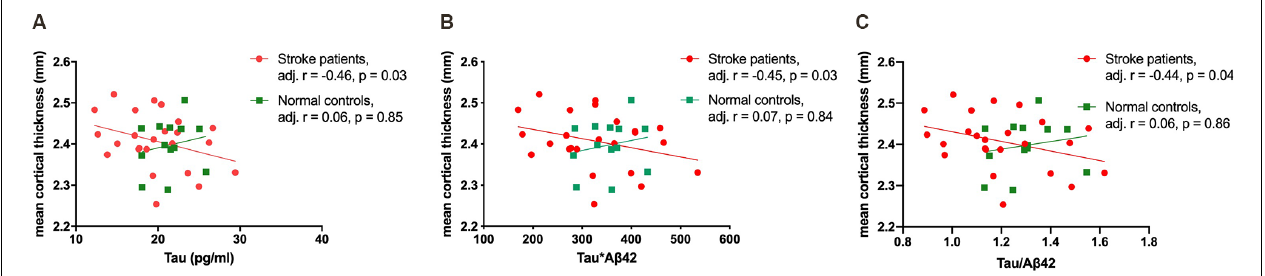
FIGURE 1 | The correlations of mean cortical thickness with plasma tau (A) , tau ∗ A β 42 (B) , and tau/A β 42 (C) in stroke patients and normal controls.